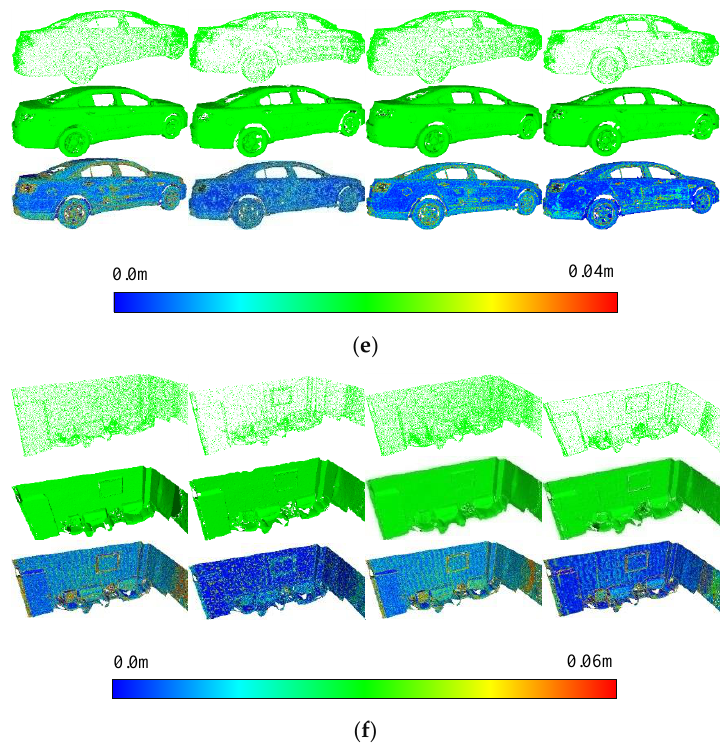
Figure 17. Comparison of simplification results. The columns from left to right represent the results of clustering, feature based, Poisson-disk, and the proposed method, respectively. ( a ) simplification results of Bodhisattva data, ( b ) simplification results of Ananda data, ( c ) simplification results of General data, ( d ) simplification results of Rabbit data, ( e ) simplification results of Car data, ( f ) simplification results of Indoor data.